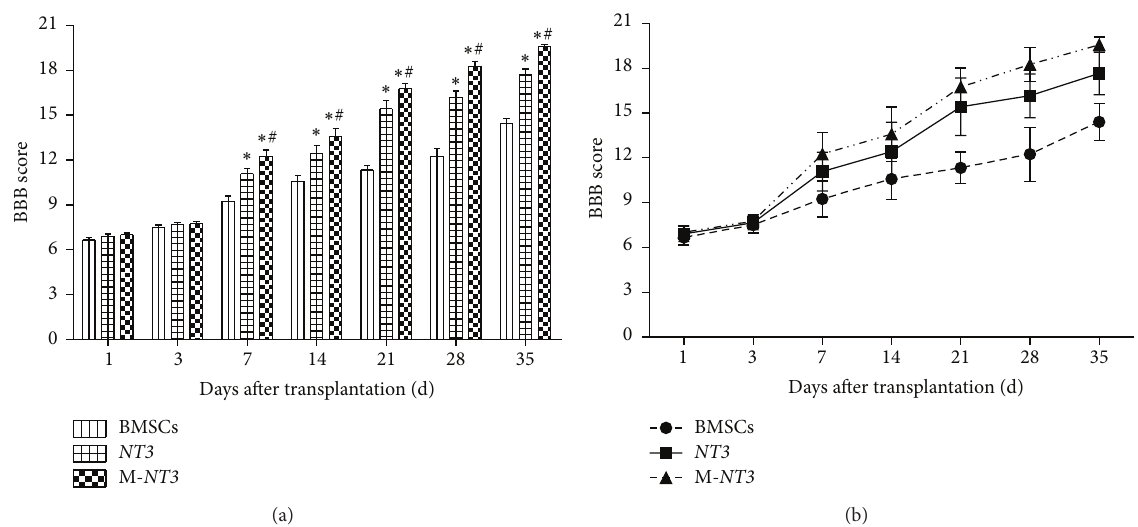
Figure 4: The BBB scores of the hind-limb locomotor functions in each group on days 1, 3, 7, 14, 21, 28, and 35 after cell transplantation ((a), (b)). The data, which are presented as the means ± SD ( 𝑛 = 12 ), were analyzed using repeated measures ANOVA. ∗ 𝑝 < 0.05 versus the BMSC group, # 𝑝 < 0.05 versus the NT3 group.